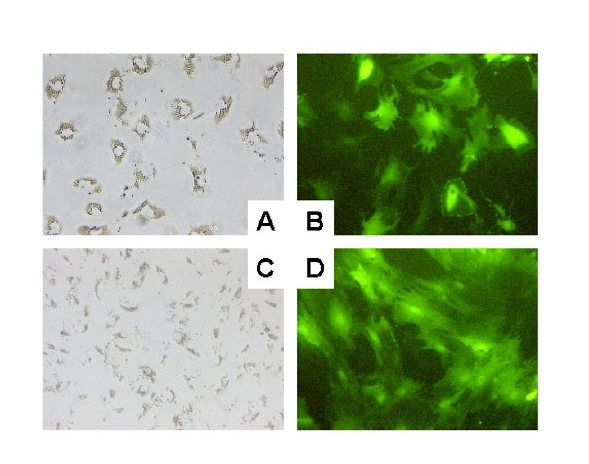
Figure 5 Adenoviral infection of rHSCs and rMFBs with Ad5- CMV-EGFP. For infection of rHSCs/rMFBs with Ad5-CMV- EGFP 10 5 cells were seeded in 2 ml medium and infected 2 days later with 500 µ l viral stock containing approximately 10 6 plaque forming units. Representative phase-contrast microscopy (A, C) and fluorescence microscopy (B, D) of rHSC (A, B) and rMFB (C, D) 48 hours after adenoviral infection are shown. Mock infected rHSCs or rMFBs are neg- ative for EGFP-expression (not